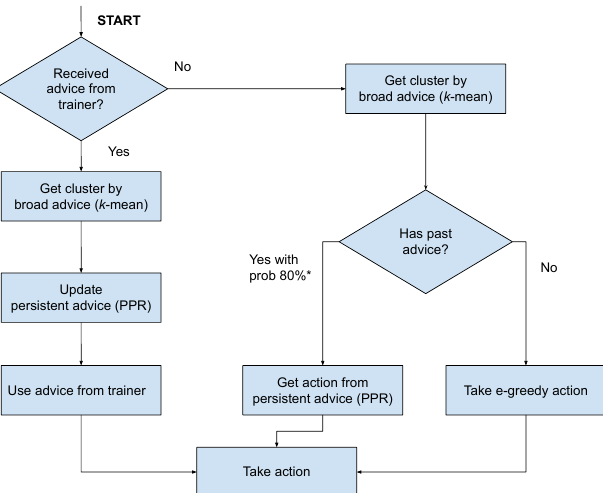
Figure 7. Flow of using broad-persistent advising. The agent will reuse previously obtained advice with an 80% chance (which decays over time) and perform its exploration policy for the remaining change (20%).